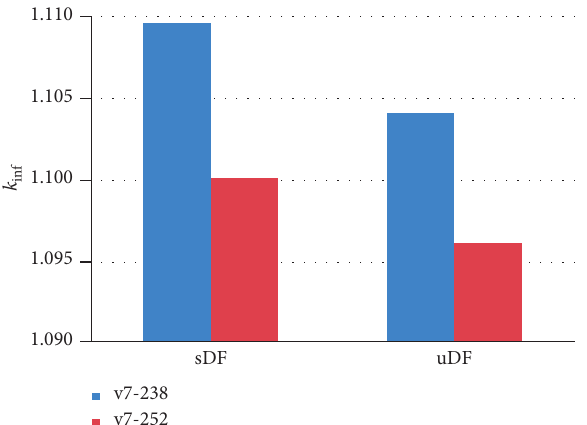
Figure 3: Neutron multiplication factor for different MG mode simulations (RBMK-1500, fresh 2% U 235